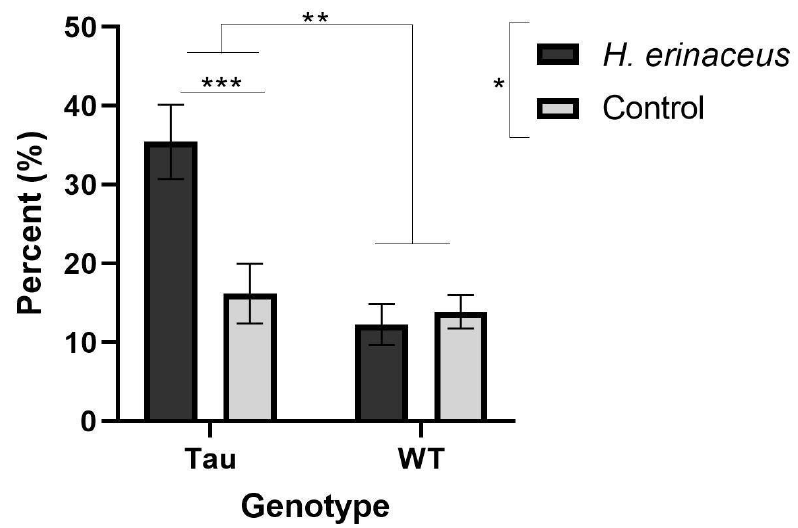
Figure 6. Percent time spent in the open arms of the EZM. Tau mice given H. erinaceus spent significantly more time in the open arms compared to tau control mice and tau mice spent more time in the open arms compared to WT mice. Mice given H. erinaceus spent more time in the open arms compared to control mice. Error bars represent mean ± SEM (* p < 0.05, ** p < 0.01, *** p = 0.001).